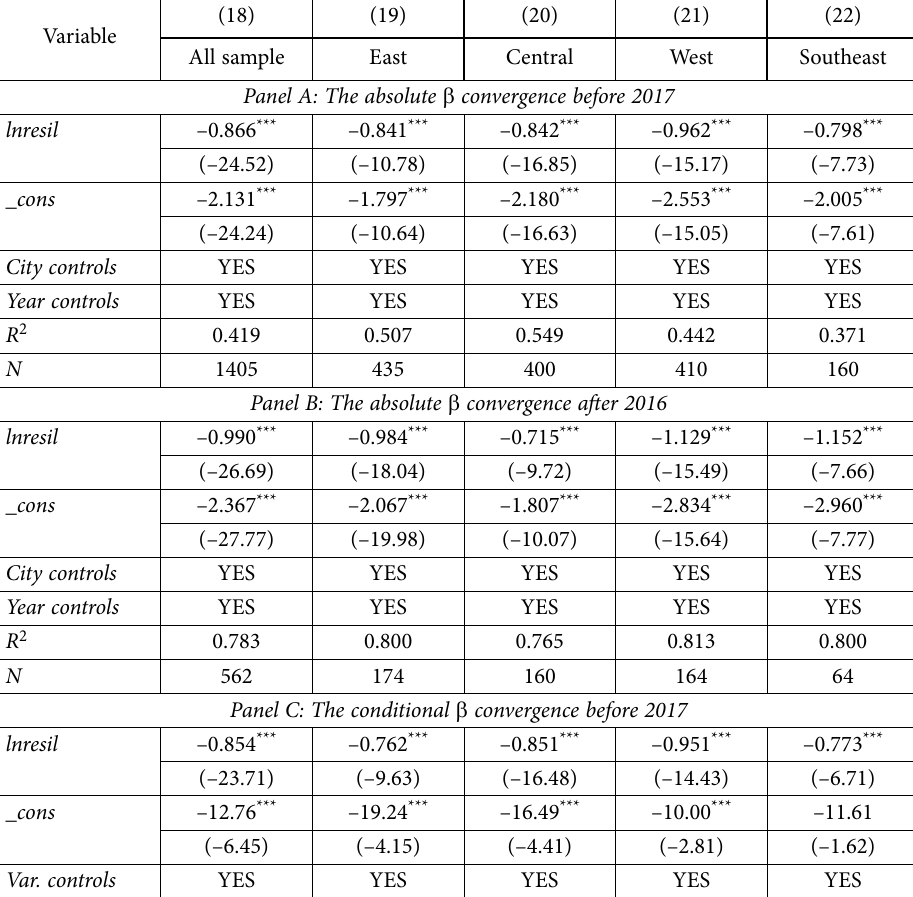
Table 8. The robustness test estimation of the β